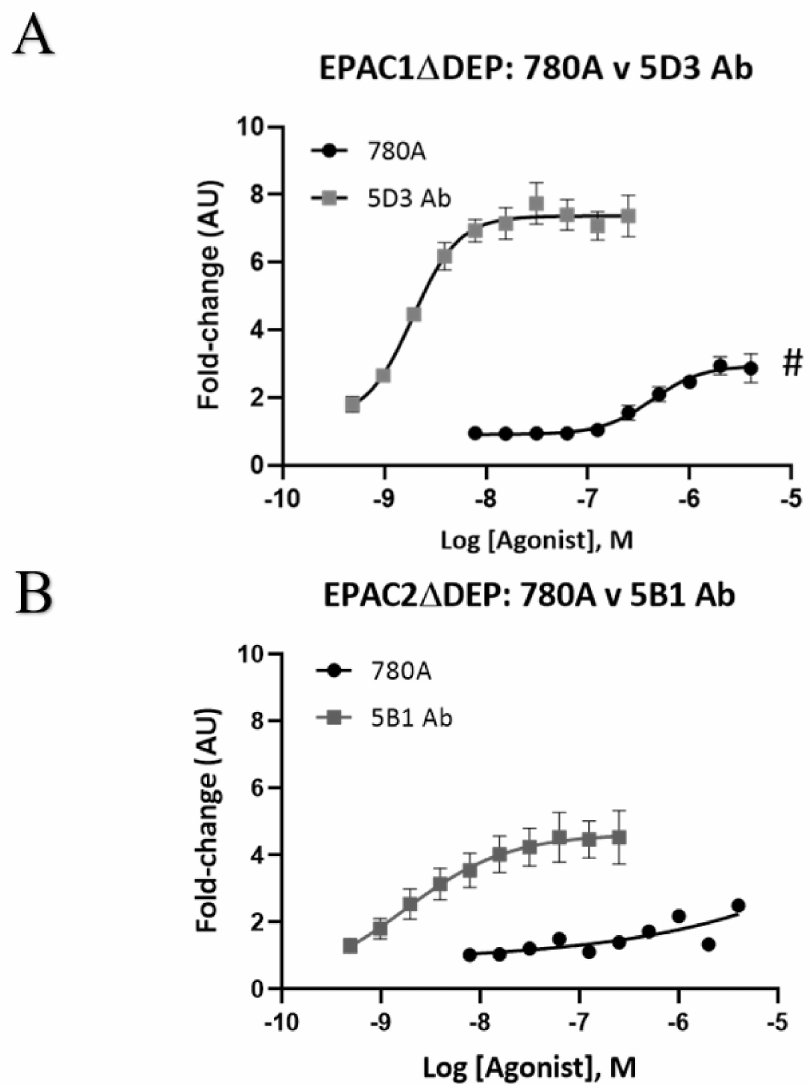
Figure 5. Relative binding affinities of Affimer 780A versus anti-EPAC1- (mAb 5D3) and anti-EPAC2- selective (mAB 5B1) antibodies for recombinant EPAC1 ∆ DEP and EPAC2 ∆ DEP proteins. For each ELISA, 1 µ g/well of GST-tagged recombinant protein, either A) EPAC1 ∆ DEP or B) EPAC2 ∆